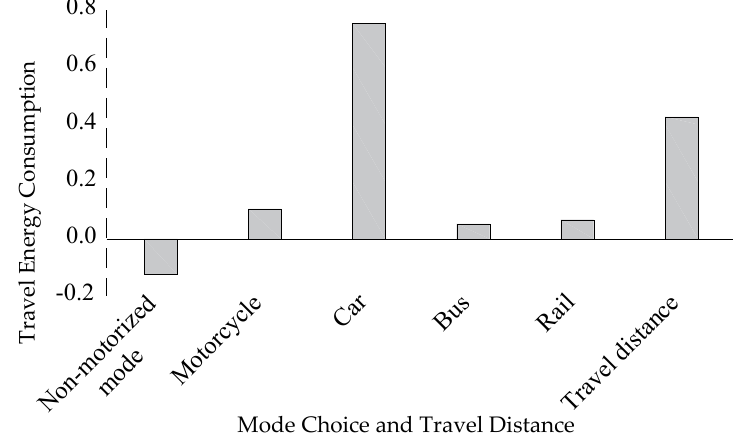
Figure 5. Effect of mode choice and travel distance on Travel energy consumption.